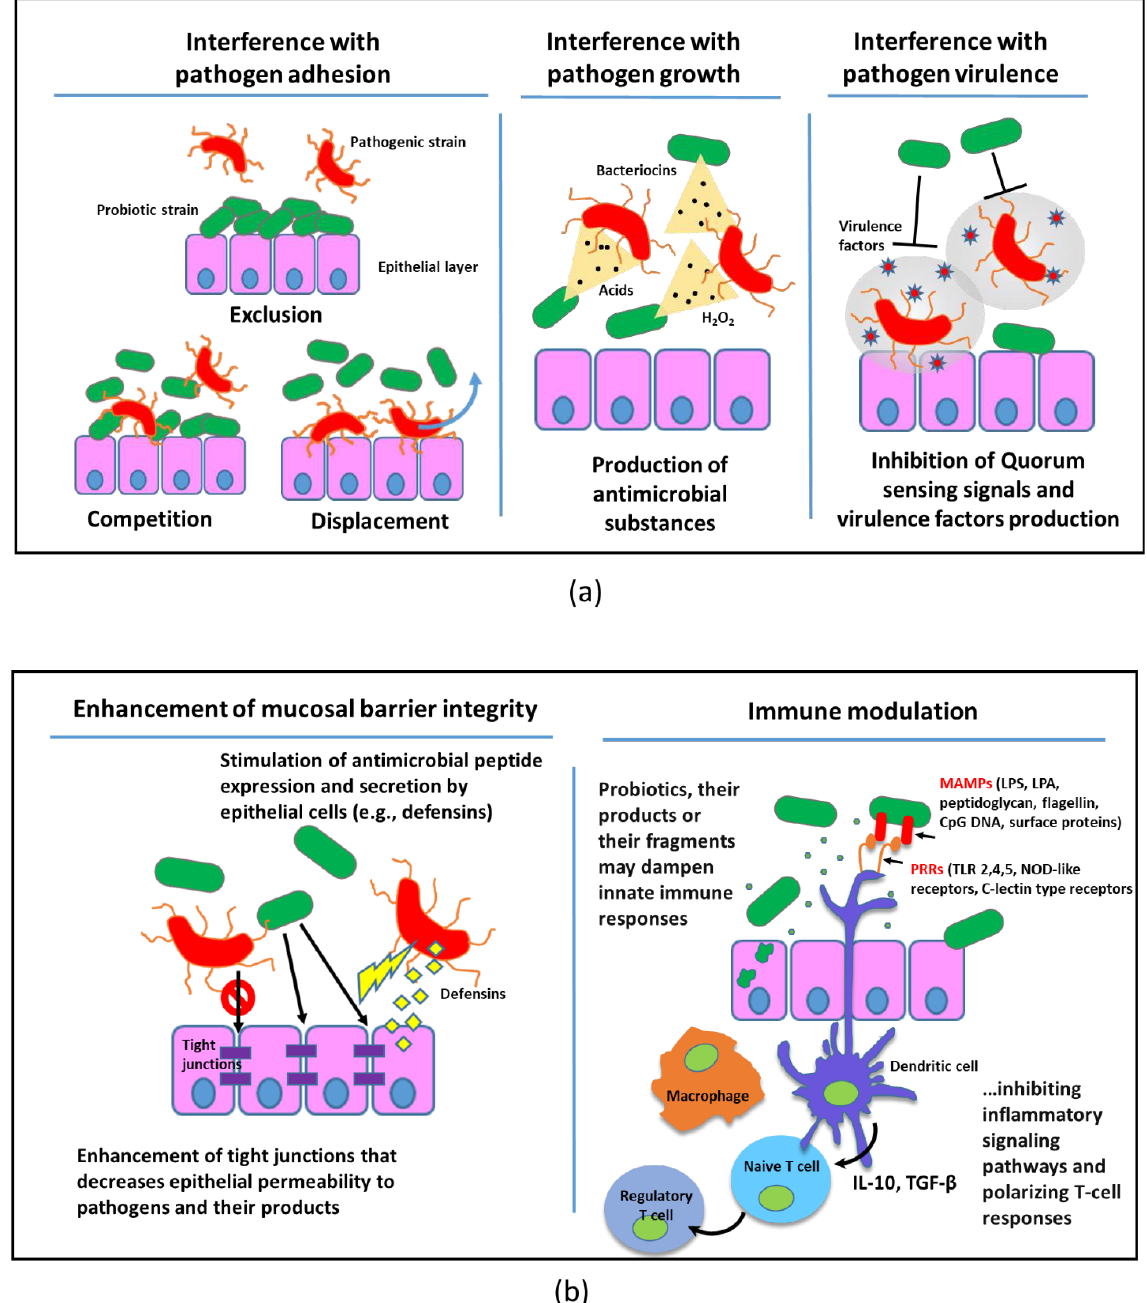
Figure 1. Mechanisms of the antimicrobial effects of probiotics at the mucosal interfaces: ( a ) direct effects; ( b ) indirect effects.